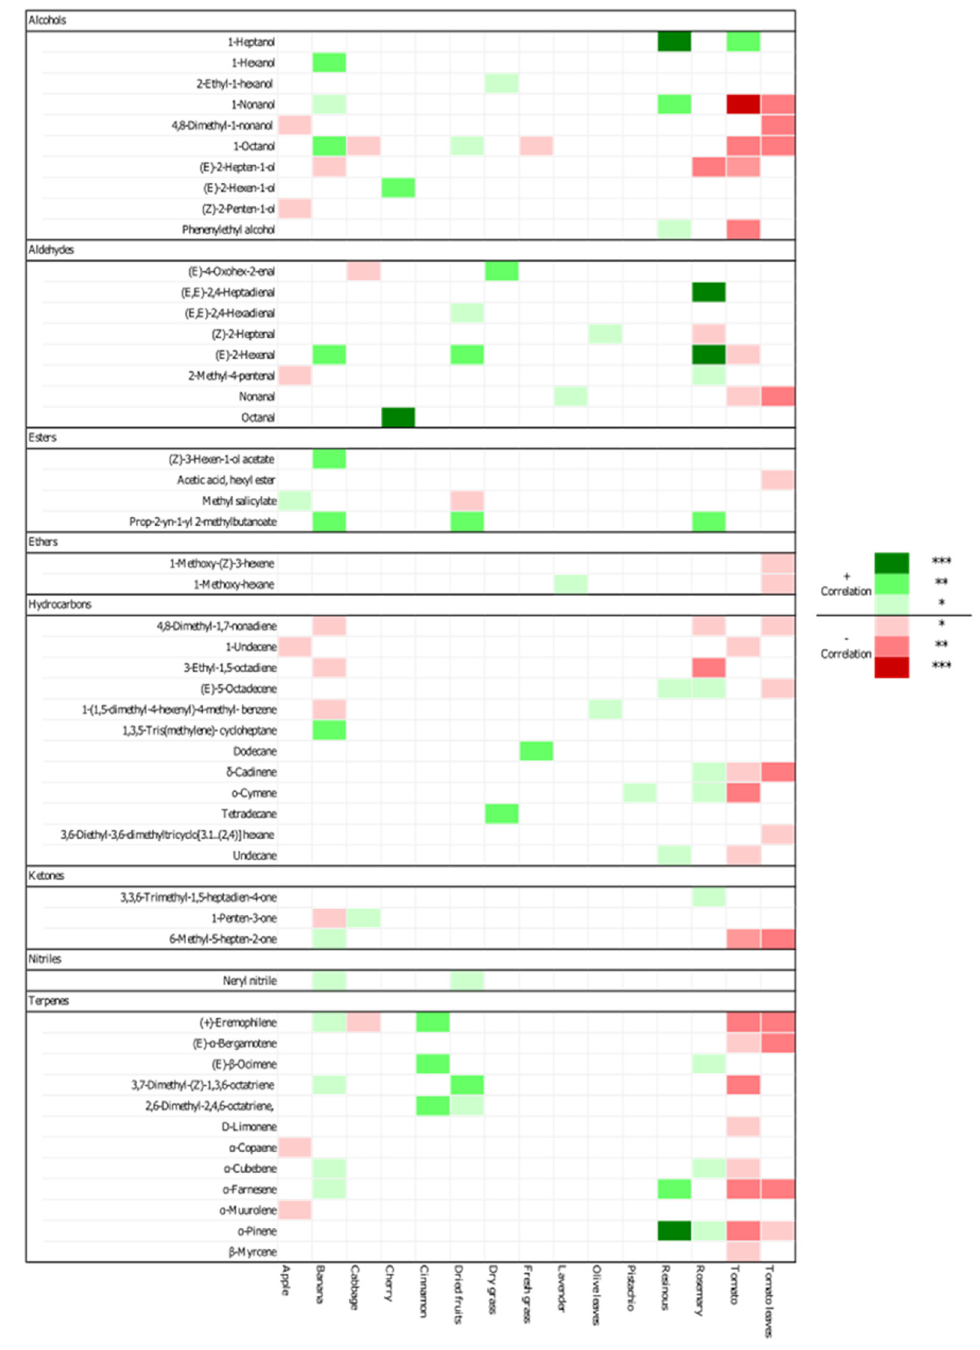
Figure 2. Pearson’s correlation test (only results with a p -value < 0.05 are shown). Note: * 0.01 < p -value < 0.05; ** 0.001 < p -value < 0.01; *** p -value < 0.001.